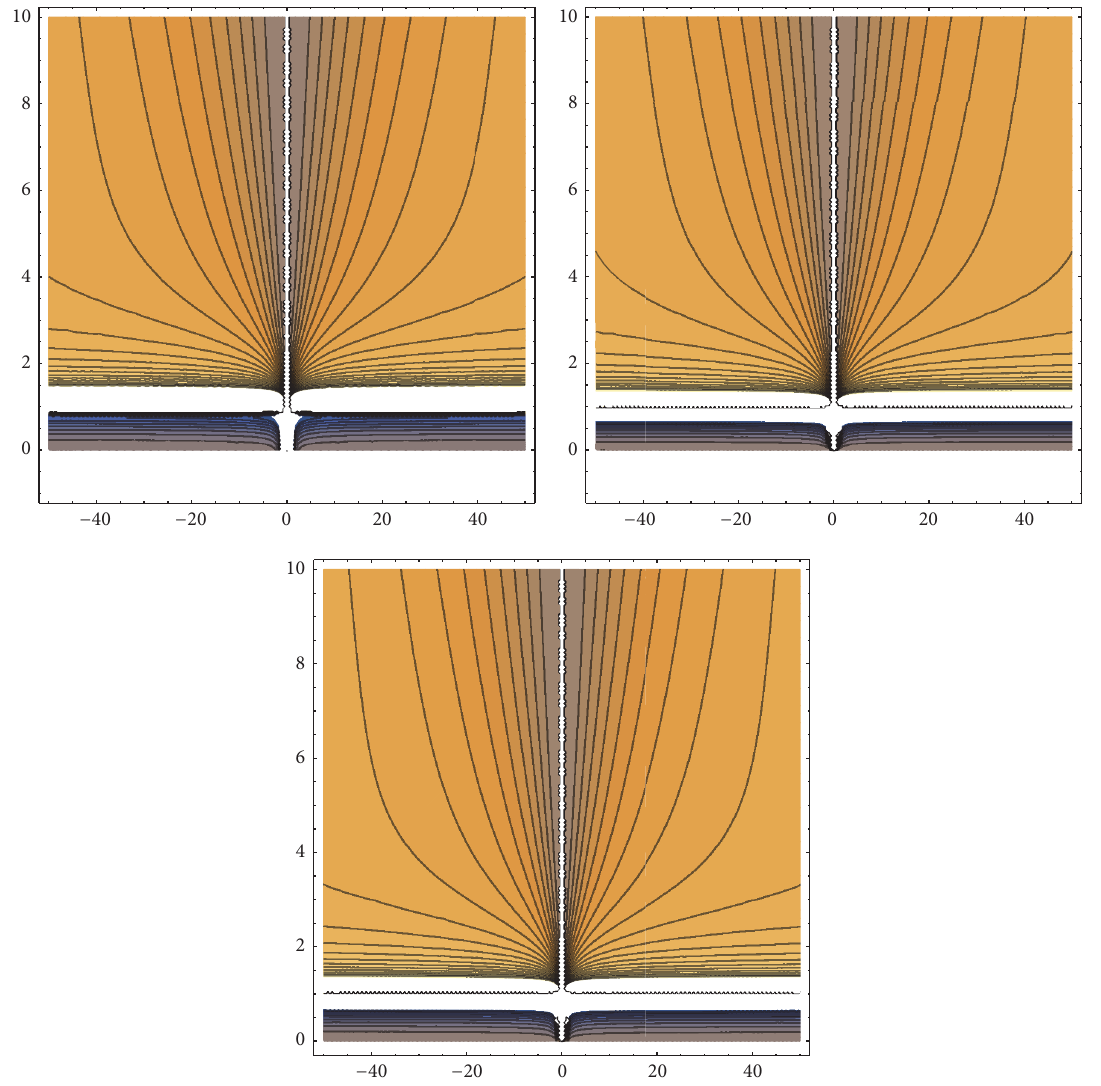
Figure 2: The figures are made, respectively, with (𝜖 = 1 , 0, − 1 ) with fixed parameters 𝑚 = 1 , 𝑞 = 1 , 𝐿 = 1 , and 𝛼 = 1 , for 30 contour lines in ranges 𝑟[−50, 50] and 𝑧[−1, 10]